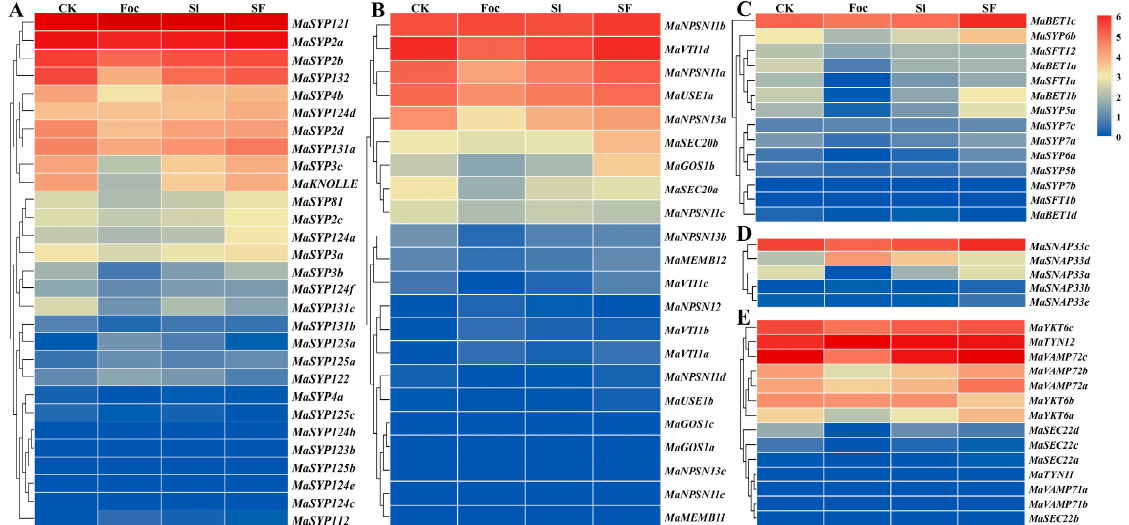
Figure 7. Heatmap for the expression of MaSNAREs in Foc TR4-, S. indica -, and their co-treated banana roots. ( A – E ): Qa, Qb, Qc, Qbc and R subfamily, respectively. CK: banana roots without S. indica and Foc TR4 treatments. Average FPKM values of three biological replications were used for the heatmap drawing. The redder the color, the higher the expression level; the bluer, the lower the expression level.